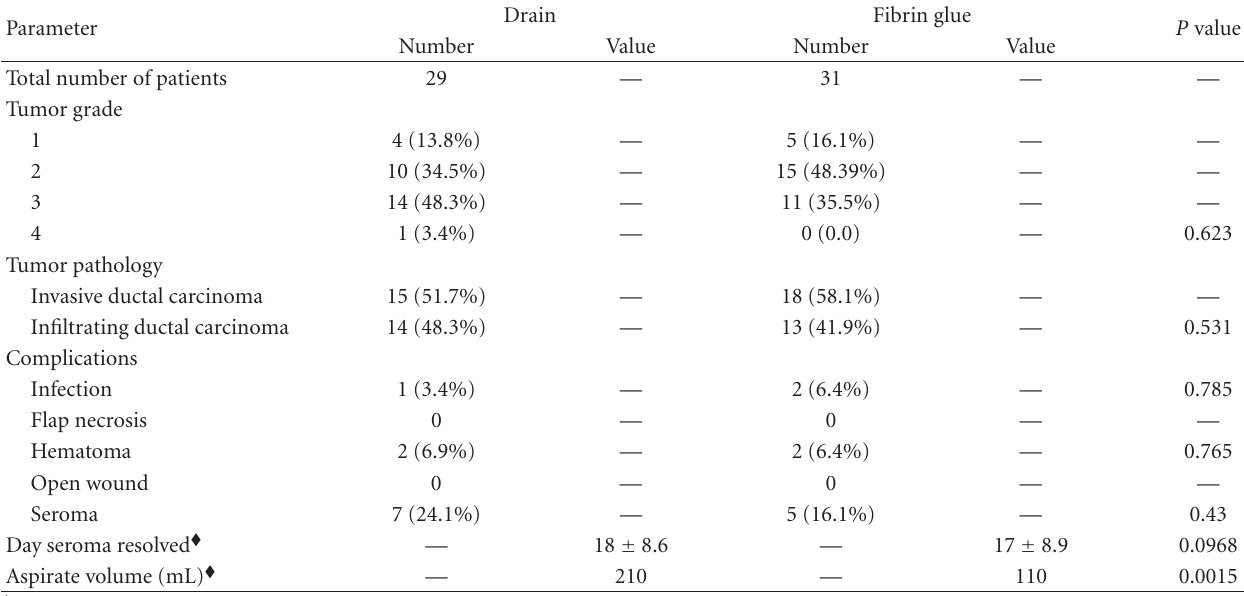
Table 3: Comparison of tumor grade, pathology, days to seroma resolution, seroma aspirate volume, and complications for the drain and fibrin glue